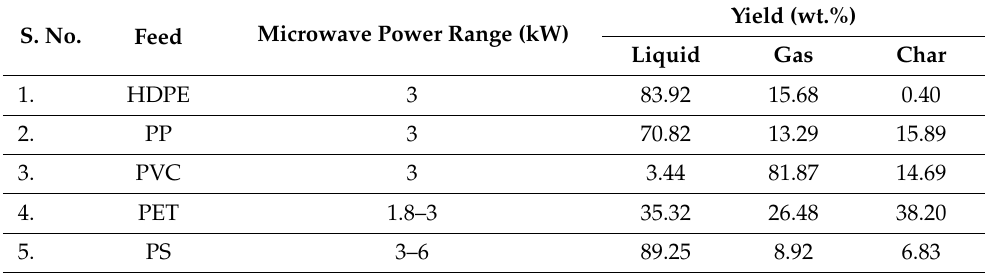
Table 2. Summary of studies on microwave pyrolysis of plastic waste. S.